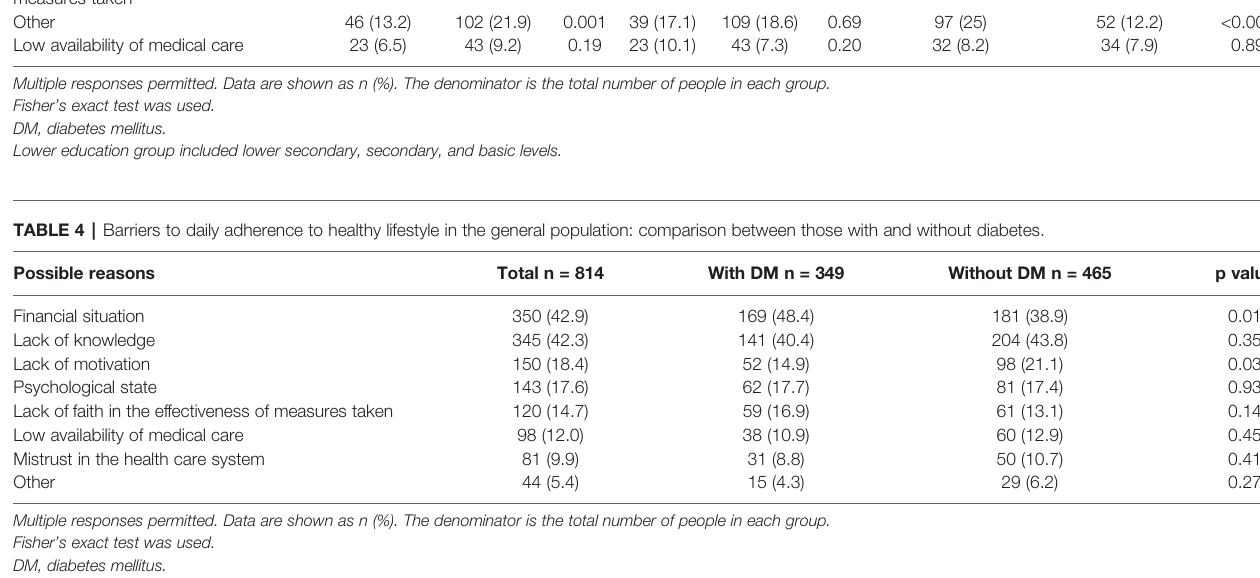
Multiple responses permitted. Data are shown as n (%). The denominator is the total number of people in each group. Fisher ’ s exact test was used. DM, diabetes